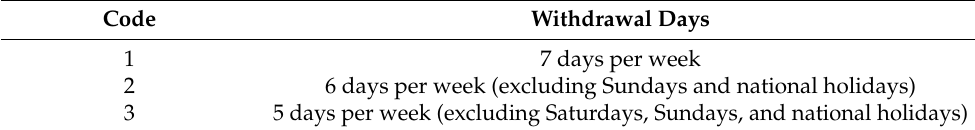
Table 3. Class of withdrawal